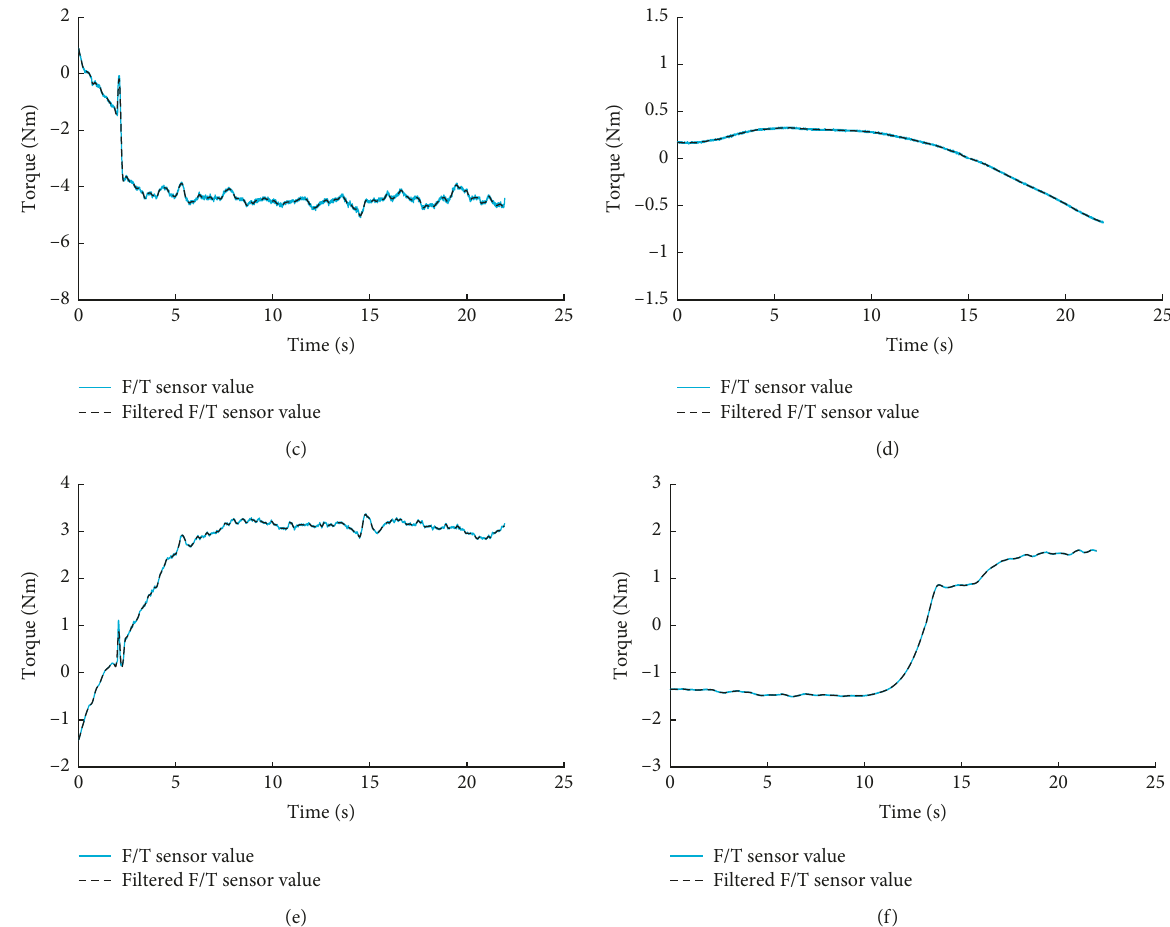
Figure 9: Joint torque values at a desired force of − 40N. (a) Joint 1 torque. (b) Joint 2 torque. (c) Joint 3 torque. (d) Joint 4 torque. (e) Joint 5 torque. (f) Joint 6